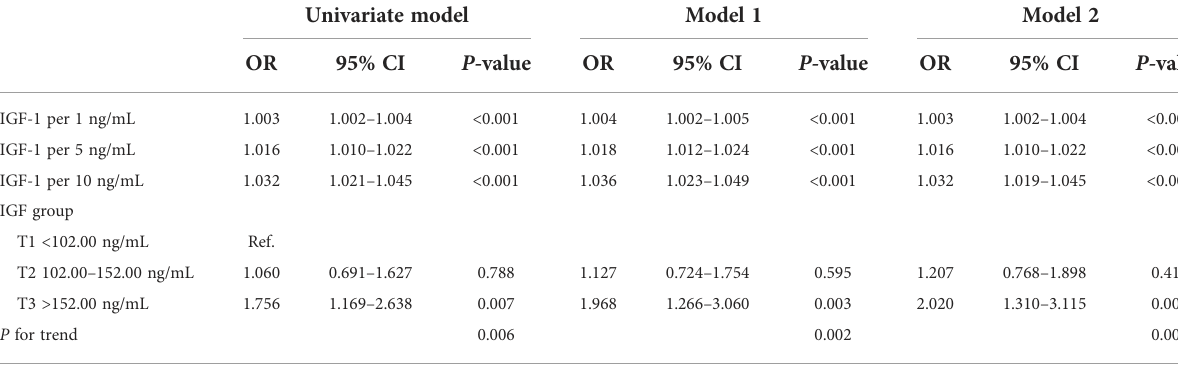
TABLE 2 The logistic regression analysis shows the relationship between insulin-like growth factor-1 and the risk of interventricular septal